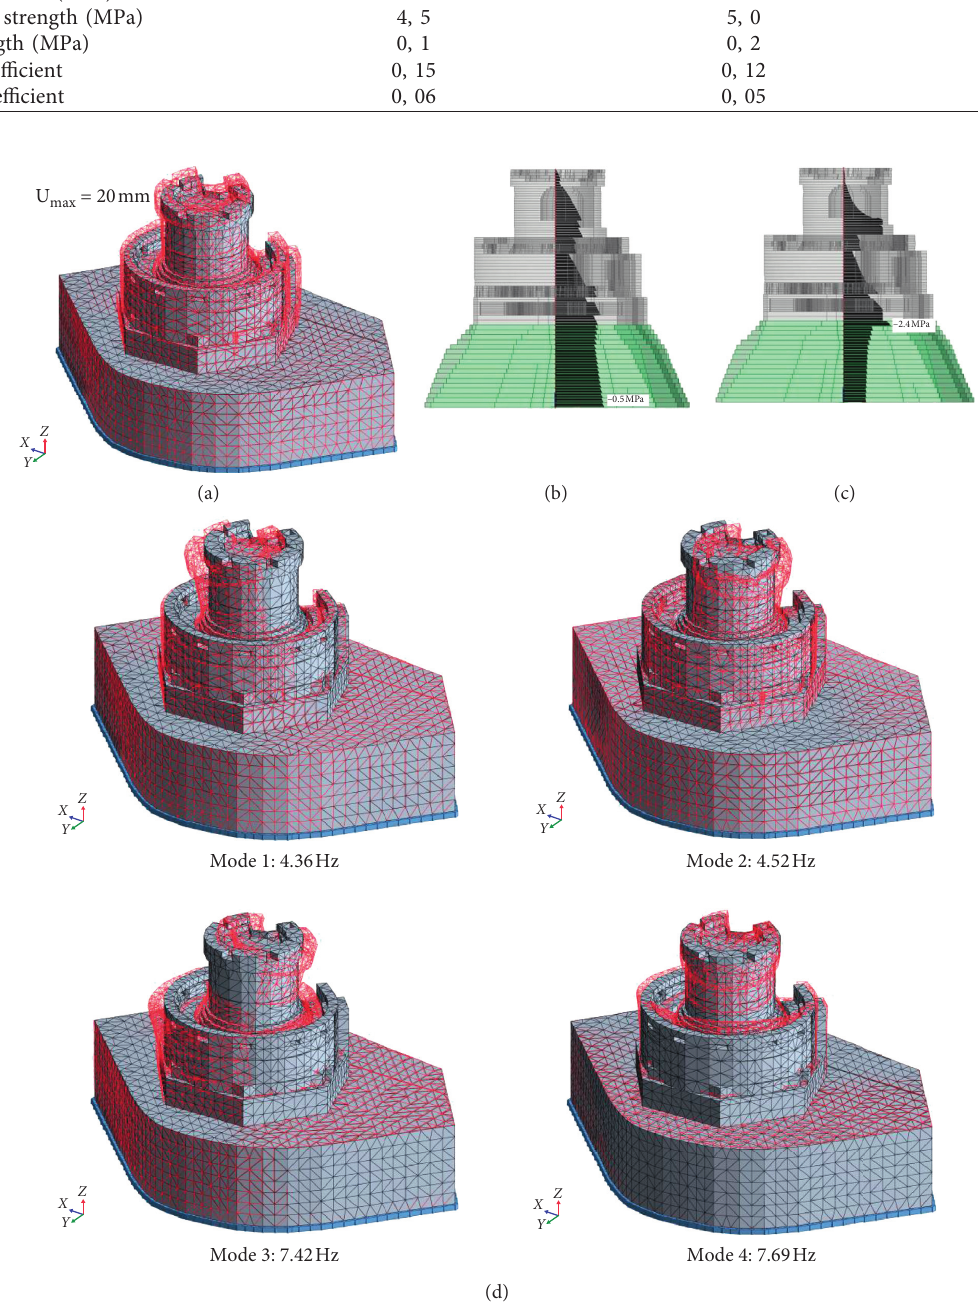
Figure 11: Some results of finite element analyses. (a) The displacements for the nonuniform temperature distribution of 10 ° C at the south side and 0 ° C at the north side. (b) The vertical stresses for the dead load (MPa). (c) The vertical stresses for the combination of the dead load and the earthquake forces for an acceleration of 0.3g(MPa), equivalent static analysis. (d) The first four mode shapes and eigenvalues of the numerical